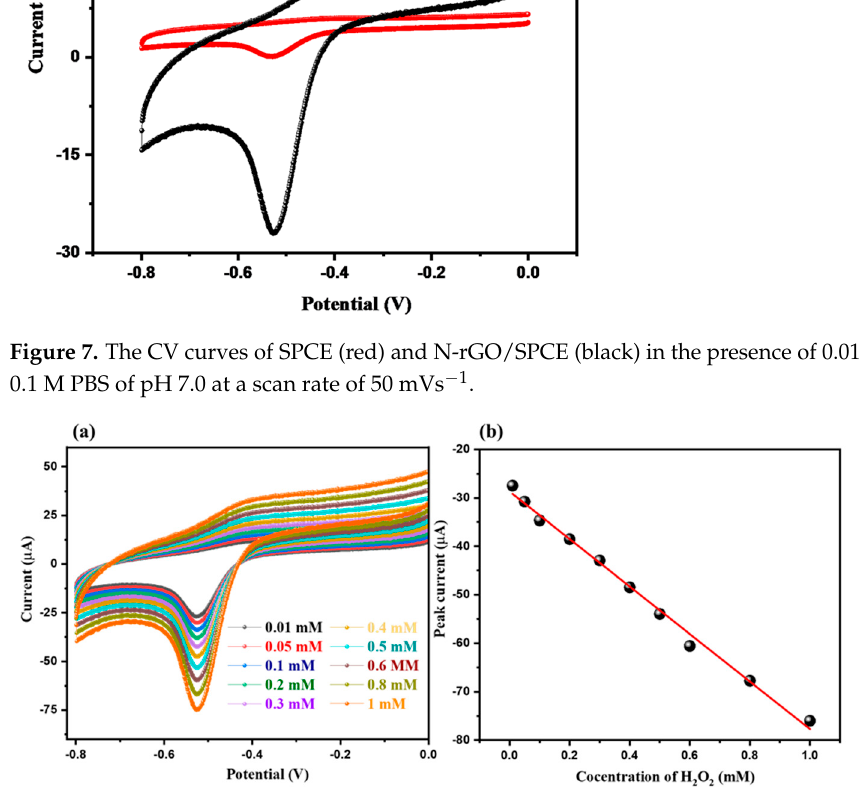
Figure 8. The CV curves ( a ) of N-rGO/SPCE in the presence of different concentrations of H 2 O 2 (0.01, 0.05, 0.1, 0.2, 0.3, 0.4, 0.5, 0.6, 0.8, and 1.0 mM) in 0.1 M PBS of pH 7.0 at a scan rate of 50 mVs − 1 and the corresponding linear calibration plot ( b ) between the peak current response versus the concentration of H 2 O 2